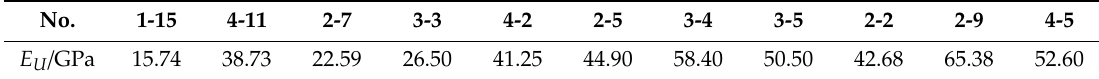
Table 5. Unloading elastic modulus parameter